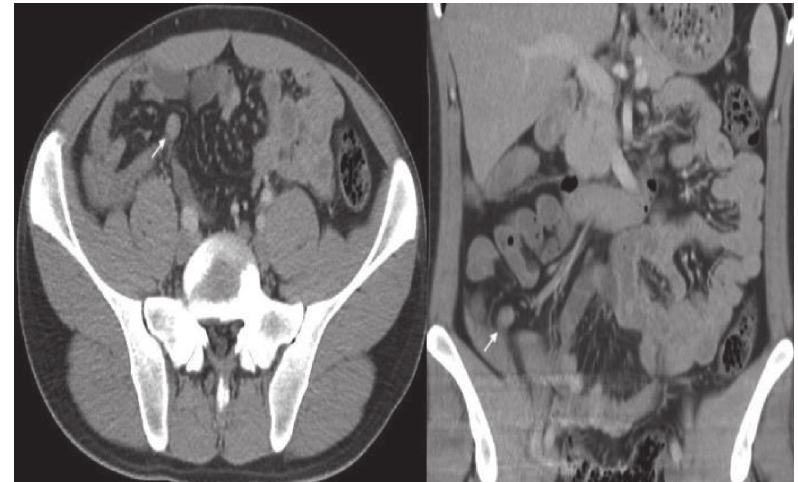
Figure 2: A suspicious mass is seen in the appendix in the axial and coronal CT scan of the same patient in the marked area.